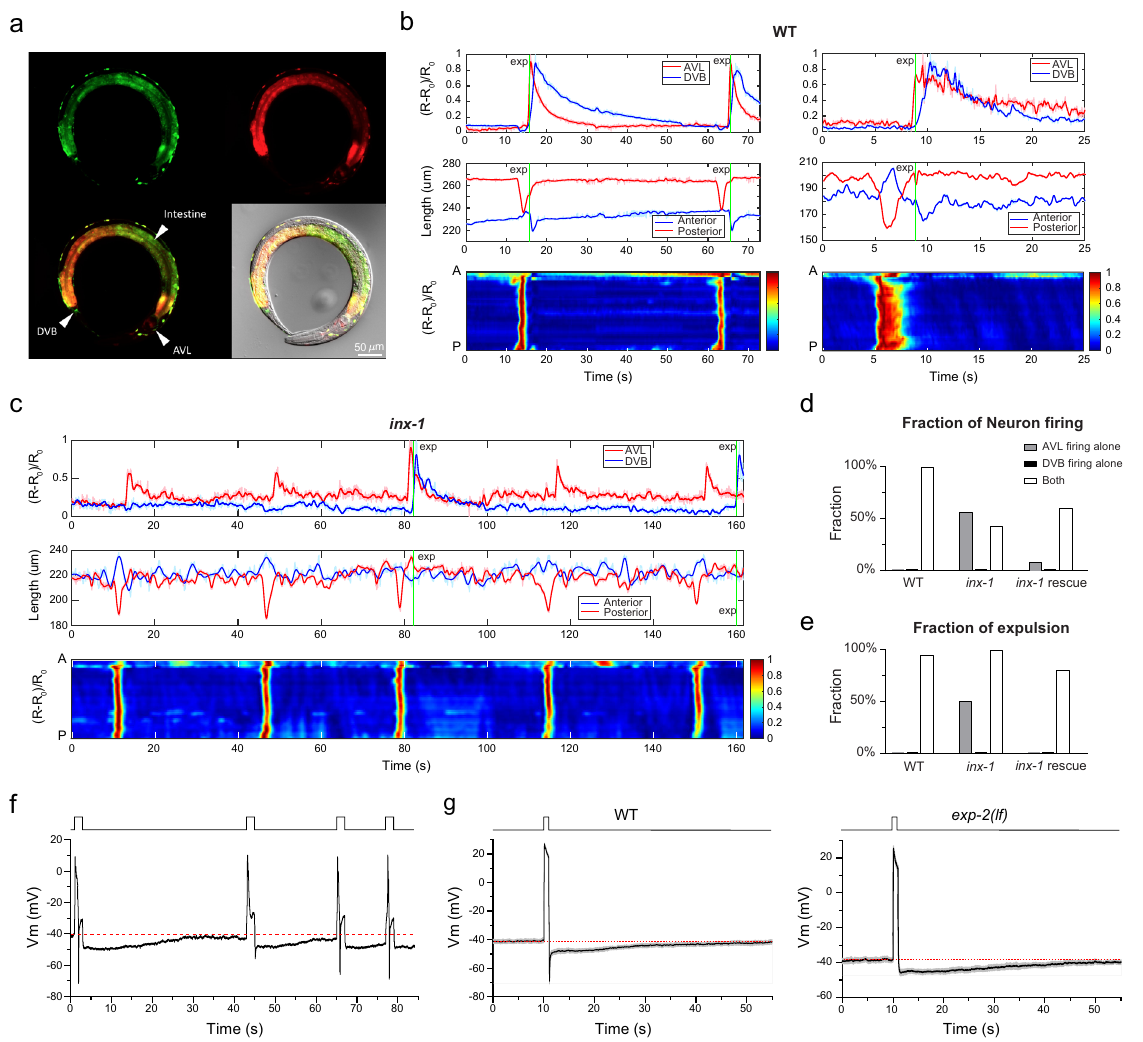
Fig. 6 Synchronous action potential fi ring in AVL and DVB underlies reliable expulsion. a Representative fl uorescent and DIC images of the dual-color imaging line used for Figs. 6, 7. An anesthetized L4 worm with co-expression of mCherry (red) and GCaMP6f (green) in all GABA neurons and the intestine. Seven randomly selected animals were imagined with near-identical results as the example shown here. b , c Top panels: Representative calcium activities of AVL (red) and DVB soma (blue) in wild-type ( b ) and inx-1 mutant animals ( c ). Middle panels: Corresponding traces showing simultaneous measurements of the length of the anterior (blue) and posterior (red) half of the centerline. Bottom panels: Corresponding normalized intestinal calcium activities along the worm body axis (A: anterior, P: posterior). Green vertical lines: Timing of expulsion. d Fraction of AVL and DVB fi ring detected in DMP cycles (WT: n = 19 from 12 animals; inx-1 : n = 14 from 3 animals; inx-1 (rescue): n = 25 from 5 animals). e Fraction of expulsion detected under the circumstances where only AVL fi res, only DVB fi res, or both neurons fi re (WT: n = 19 from 12 animals; inx-1 : n = 14 from 3 animals; inx-1 (rescue): n = 25 from 5 animals). In d , e , the values for AVL or DVB fi ring alone in WT and DVB fi ring alone in inx-1 are zero. f A representative current-clamp recording trace of AVL under repetitive stimuli (each stimulus is 3-s long at 2 pA) at various intervals. g The averaged trace of prolonged current-clamp recording of AVL under a 1-s long 8 pA stimulus in WT (left panel) and exp-2 ( lf ) mutant (right panel). Gray: SEM, n = 7. Red dotted lines in f , g label the resting membrane potential. Source data are provided as a Source Data fi